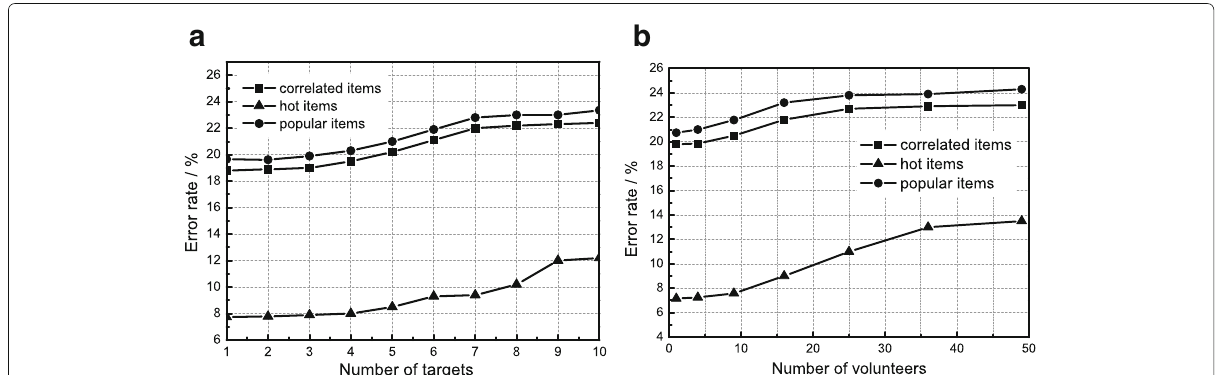
Fig. 10 a Clustering error rate under a different number of target goods. b Clustering error rate under a different number of customers